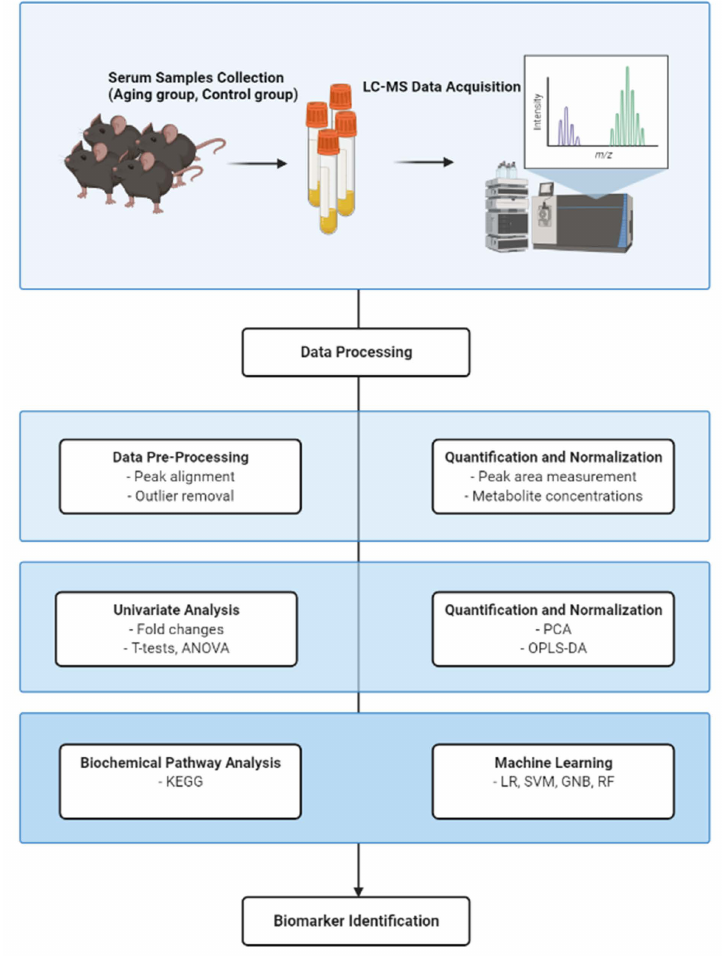
Figure 1. Overview of the workflow of the comprehensive analysis of metabolome in aging mice. ( a ): Serum samples were collected from aging mice and control mice, and the metabolite data were obtained by LC-MS/MS. ( b , c ): Data processing by peak extraction, peak alignment, and metabolite identification. ( d ): The results of Fold change and Student’s T-Test obtained from univariate analysis were combined to screen for differential metabolites. ( e ): PCA and OPLS-DA were used to reduce the dimensionality of multivariate raw data, and the similarity and difference between and within the sample groups were obtained. ( f , g ): Metabolite classification and functional annotation were carried out, and machine learning was used to search for